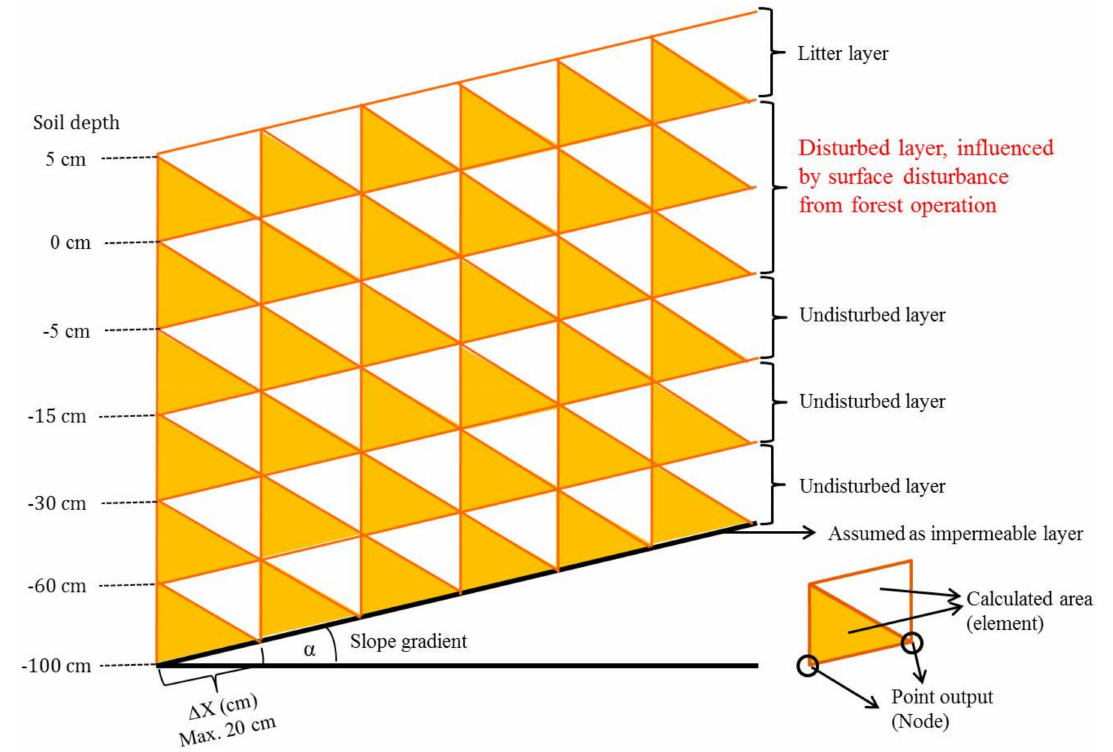
Figure 3. Scenario setting for two-dimensional saturated soil water flow simulation model.